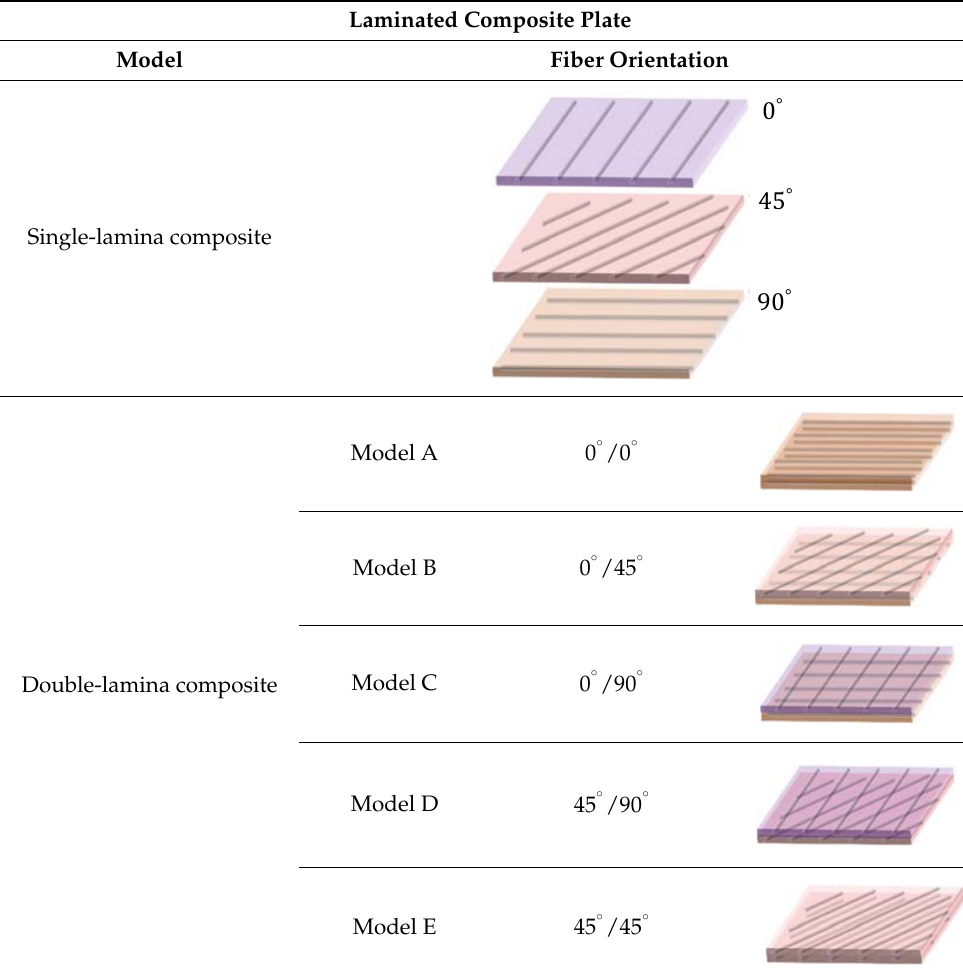
Table 1. Proposed laminated composite models.